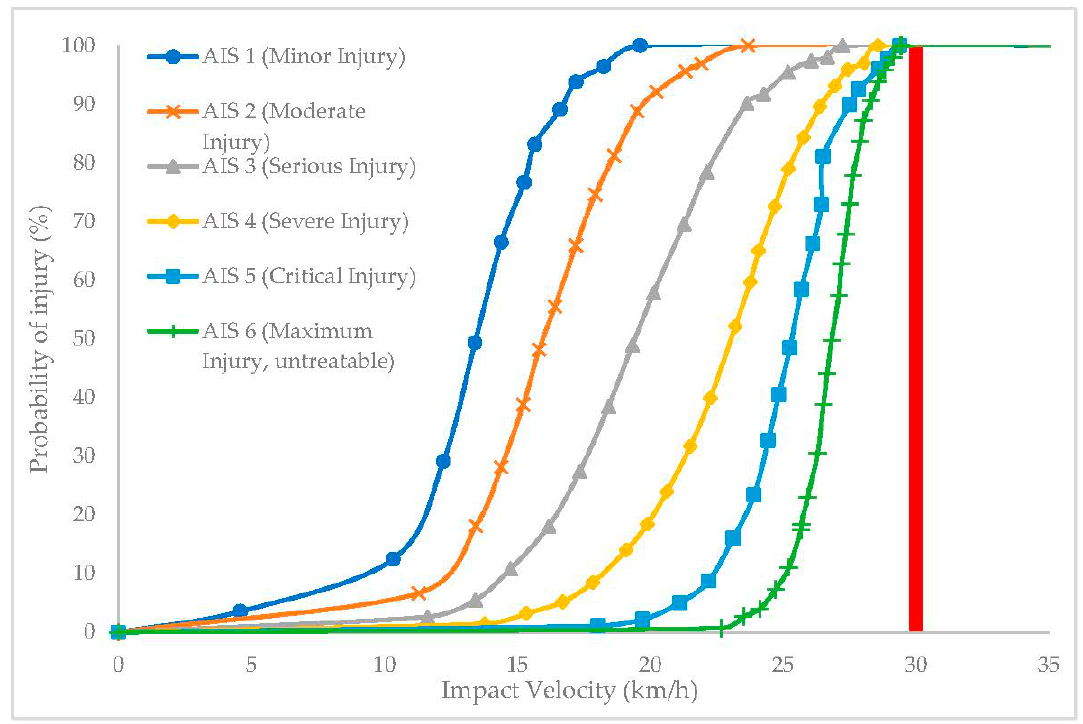
Figure 11. Probability of head injury modes based on impact velocity.